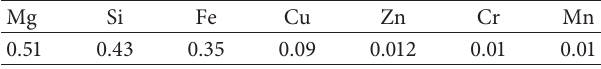
Table 1: AA 6063 aluminum alloy chemical composition.